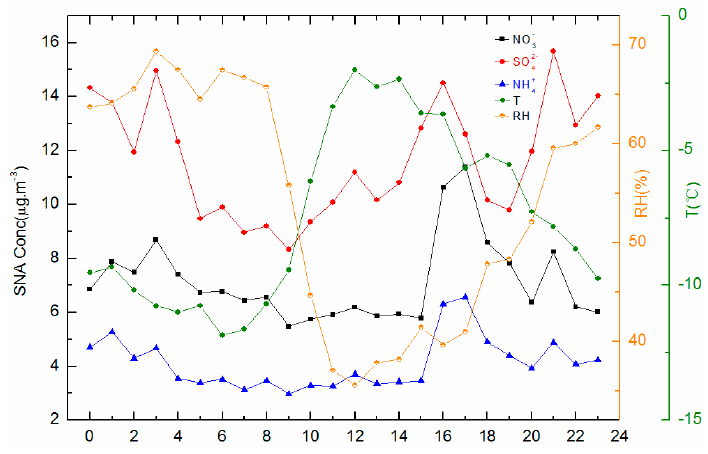
Figure 7. Diurnal variations in SO 42 − , NO 3 − , and NH 4+ (SNA), relative humidity (RH, %), and temperature (T, °C) on non-haze days.